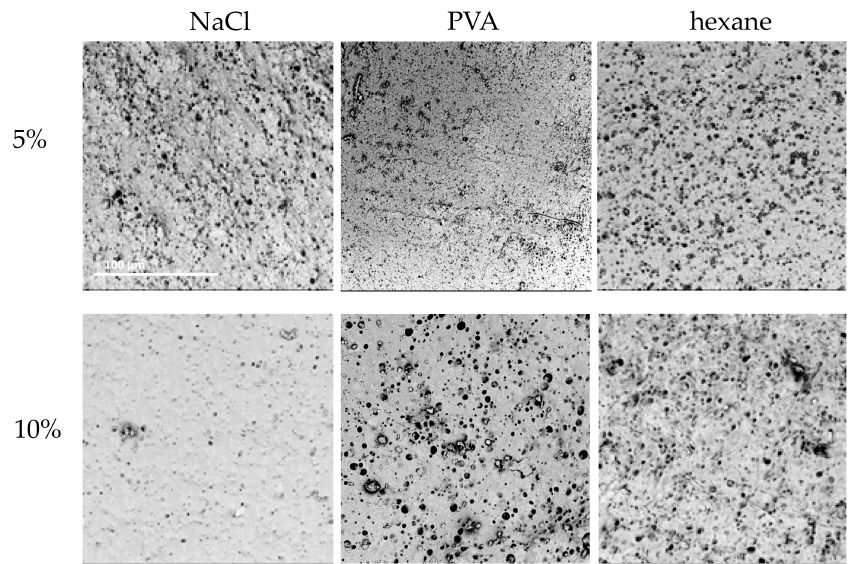
Figure 8. Morphology of internal surface of cylindrical scaffolds obtained from ChronoFlex C45D (20%, 0:100 water/EtOH, 24 h) with the addition of different porogens; scale bar: 100 µ